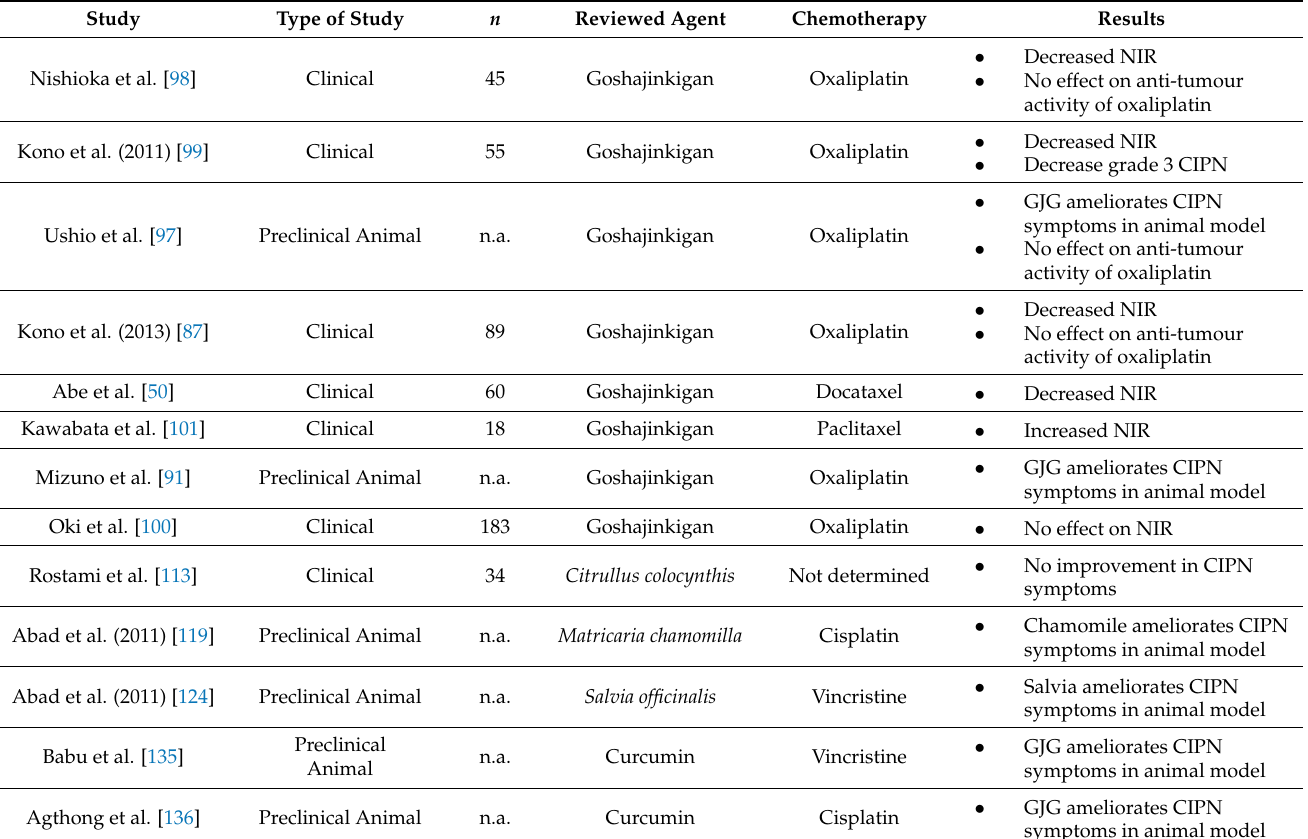
Table 5. Efficacy of medicinal plants and herbal medicines in